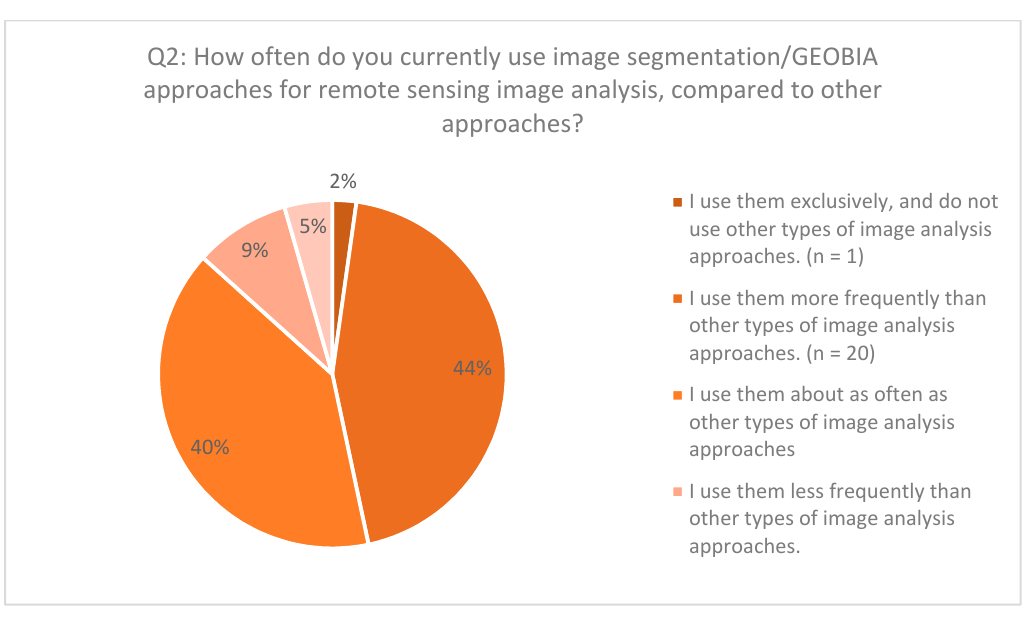
Figure 3. Responses to question 2 (Q2) of the online survey. Remote Sens. 2020 , 12 , x FOR PEER REVIEW